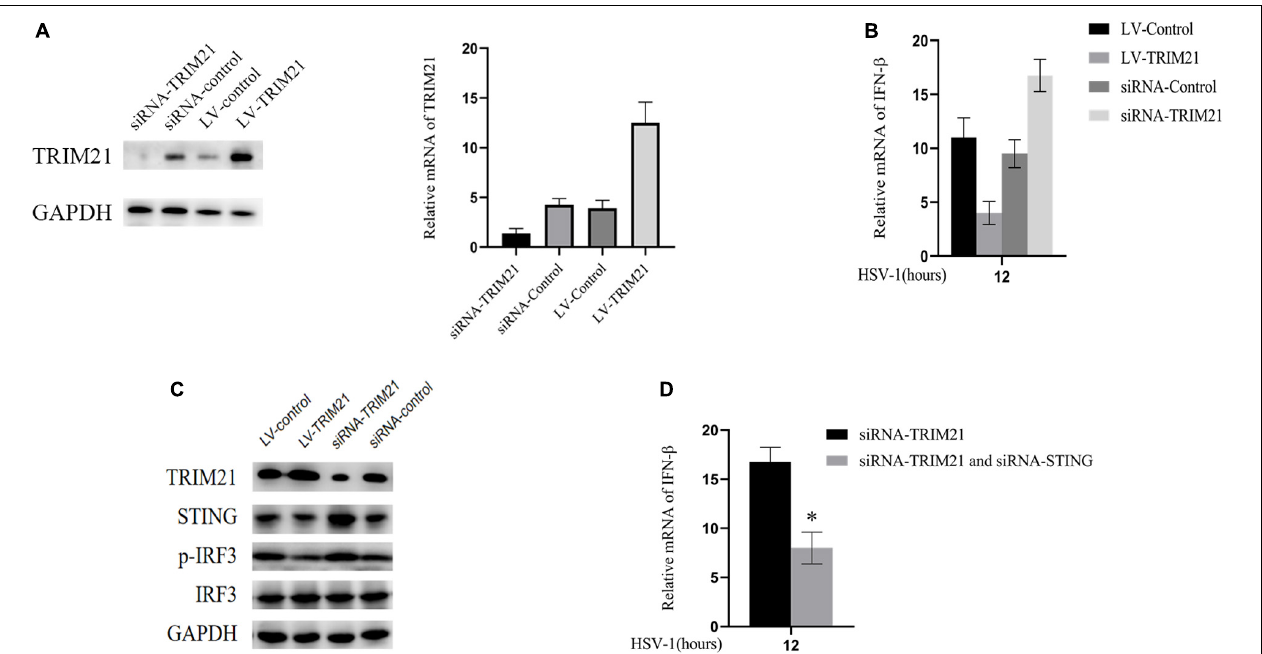
FIGURE 5 | TRIM21 inhibited STING-IRF3 signaling in HSV-1-infected HCE cells. (A) The protein (left) and mRNA levels (right) of TRIM21 in HCE cells were assessed to confirm the transfection efficiency of lentivirus and siRNA before HSV-1 infection. (B) The mRNA level of IFN- β in each group was examined after HSV-1 infection 12 h. (C) The protein expression levels of TRIM21, STING, phosphorylation of IRF3, and IRF3 were examined after HSV-1 infection 12 h. (D) HCE cells pretreated with both siRNA-TRIM21 and siRNA-STING. After HSV-1 infection 12 h, qPCR detected the production of IFN- β . Data are shown as mean ± SD of three independent experiments. ∗ P <